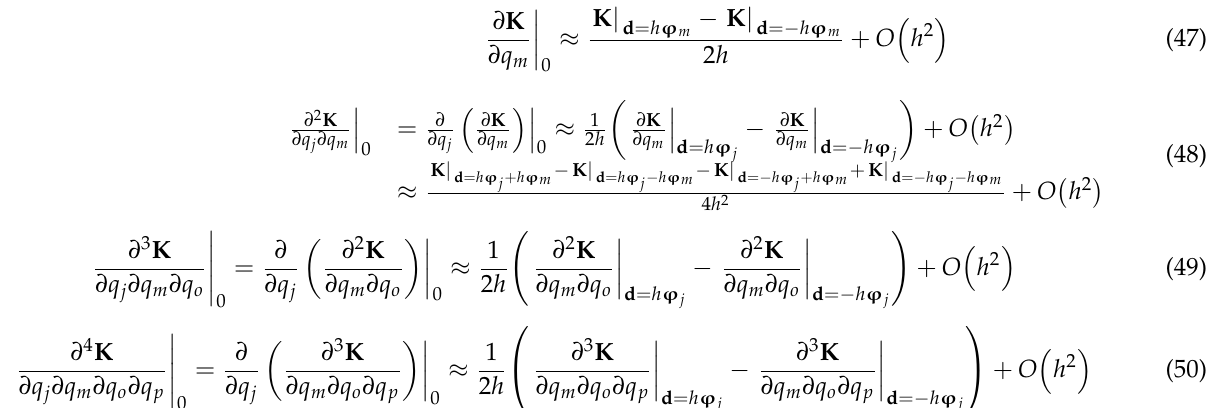
derivatives, the central difference method can be used as